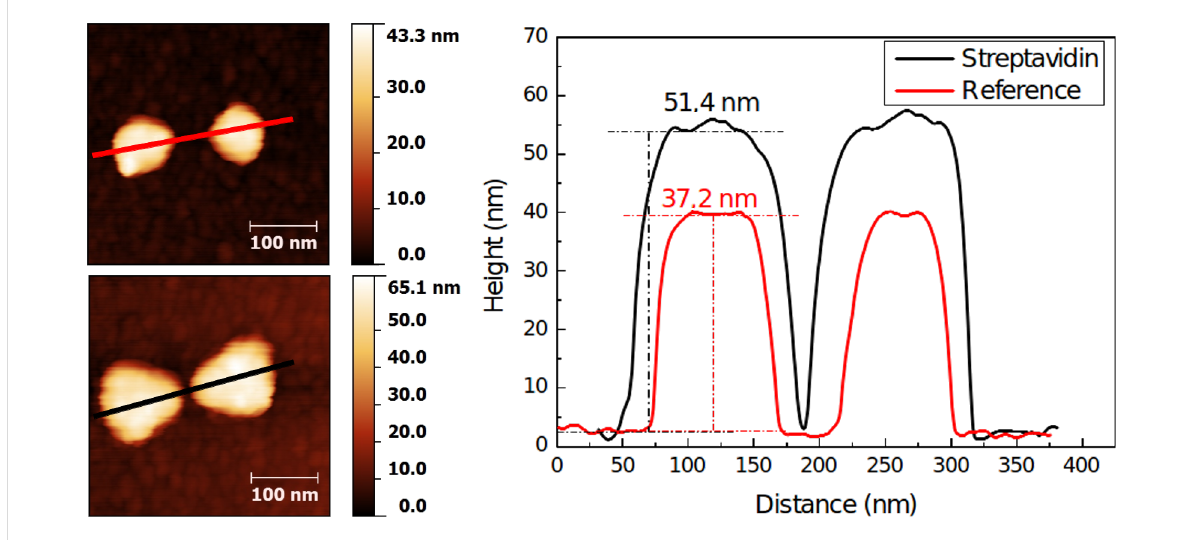
Figure 5: AFM height profiles of gold nanostructures on silica. The reference sample (red) was not functionalized or subjected to protein incubation and shows a height consistent with the deposition of 8 nm Ti + 30 nm Au. The streptavidin sample (black) was orthogonally functionalized and subjected to protein immobilization. The increase in size is indicative of the binding of streptavidin on the nanostructure.